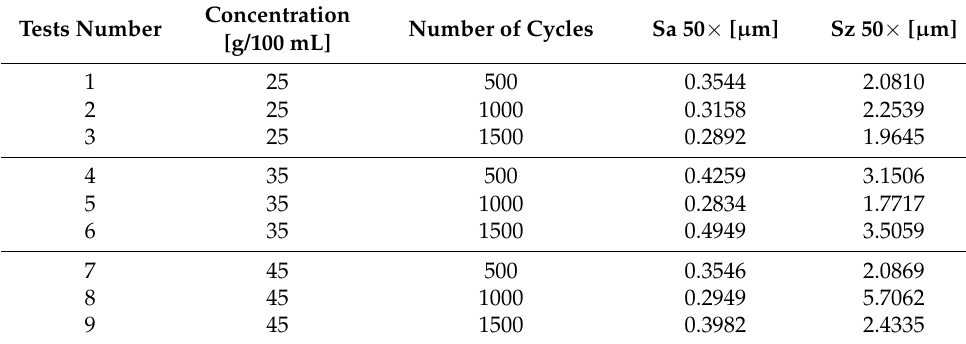
Table 4. Data collected in the analysis of craters by 3D